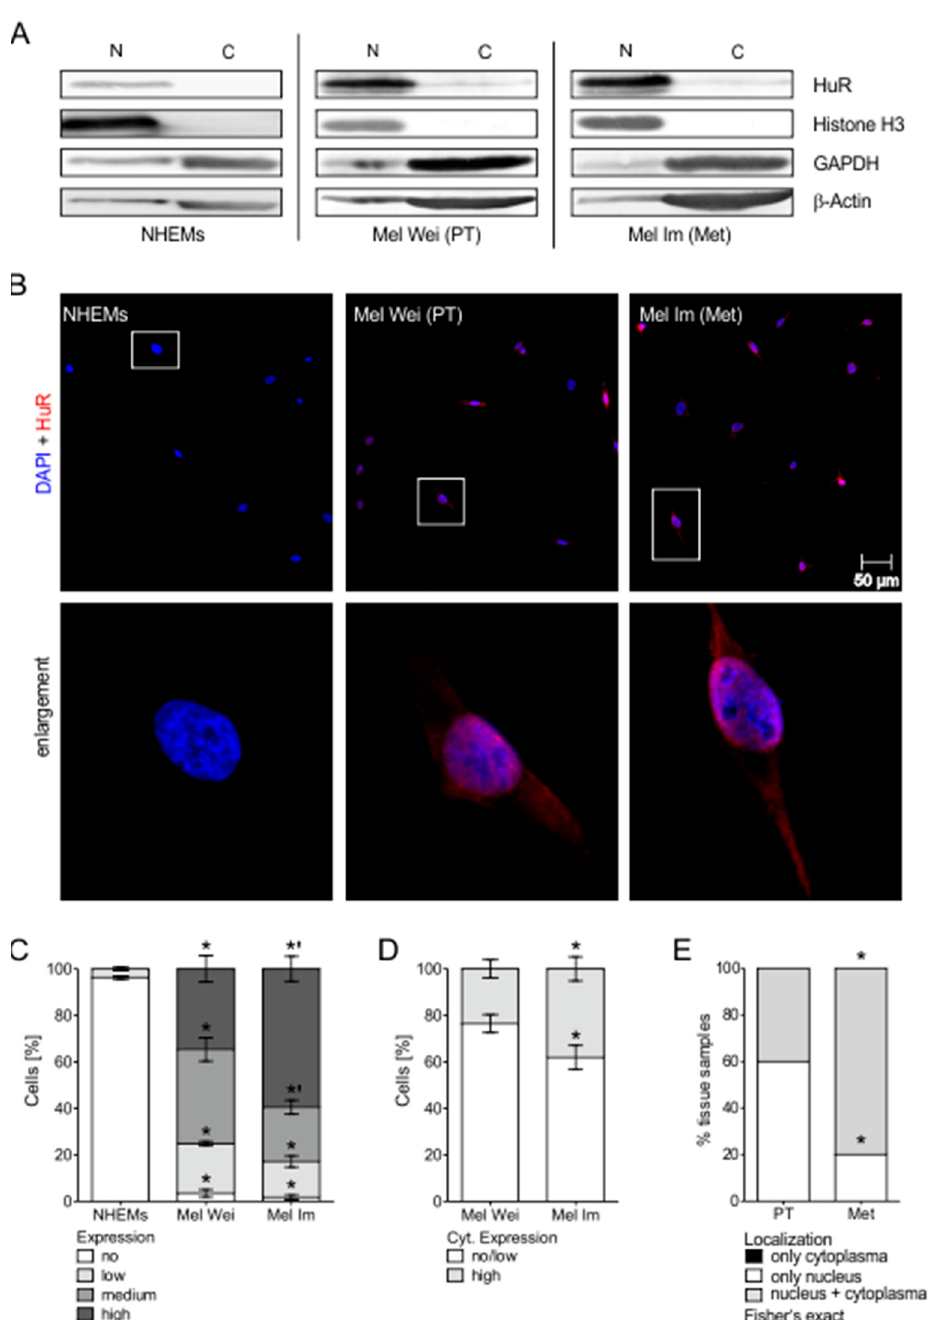
Figure 3. Changes of HuR expression and localization in the progression of MM in vitro . ( A ) Fractionation of cell lysates of NHEM, Mel Wei, and Mel Im cells in nucleus and cytoplasm fraction and subsequent Western blot analysis of HuR protein. Histone H3 served as a nucleus control, GAPDH and β -actin as cytoplasm controls. Representative pictures shown. ( B ) Representative immunofluorescence pictures of NHEM, Mel Wei, and Mel Im cells stained with DAPI (blue) and HuR (red). ( C ) Percentage of no, low, medium, or high HuR level in IF-staining in NHEM, Mel Wei, and Mel Im cells. Significant comparisons with NHEMs were marked with *, significant comparisons between Mel Wei and Mel Im with ‘. ( D ) Percentage of only nuclear/low cytoplasmic and high cytoplasmic HuR level in IF-staining in Mel Wei and Mel Im cells. ( E ) Percentage of only nuclear/nuclear and cytoplasmic HuR localization in IH-staining of primary tumor and metastasis melanoma tissue samples (see Figure 1F). *A p -value of <0.05 was considered statistically significant. The uncropped blots and molecular weight markers of Figure 3A are shown in Figure S7.